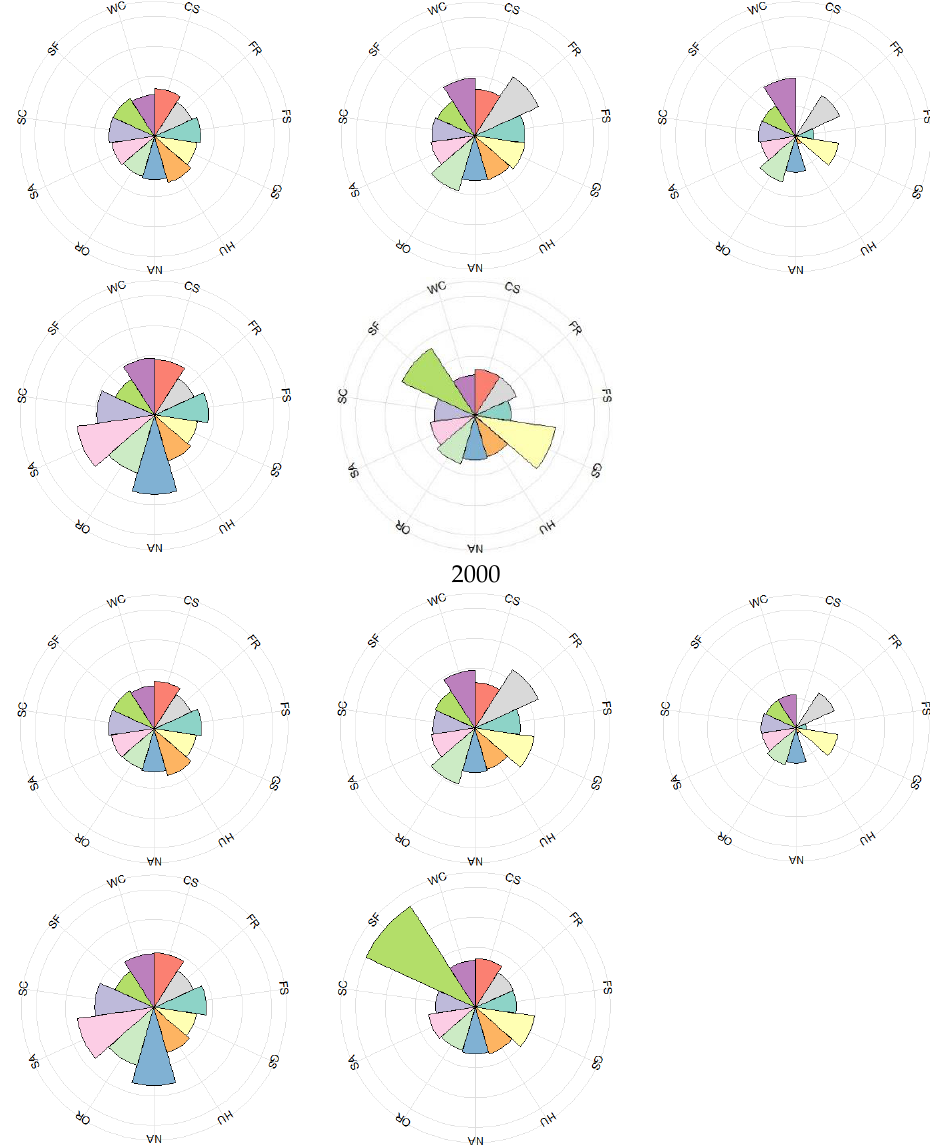
Figure 5. Distribution of ES in each ES bundle in Shenyang, food supply (FS), grass supply (GS), water conservation (WC), carbon sequestration (CS), SO2 absorption (SA), NOx absorption (NA), humidification (HU), soil conservation (SC), flood regulation (FR), soil fixation (SF), outdoor recre- ation